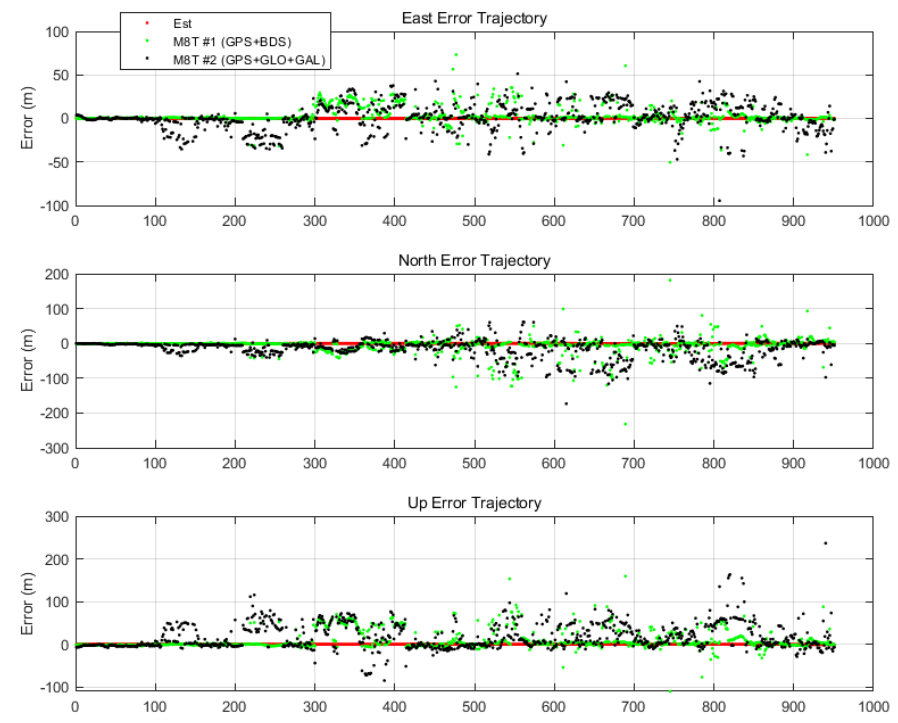
Figure 13. Time history of east – north – up (ENU) errors with standalone positions. The red points indicate ENU errors of the proposed TDCP / INS navigation system, the green points indicate errors of the standalone position of M8T #1 (GPS and BeiDou), and the black points